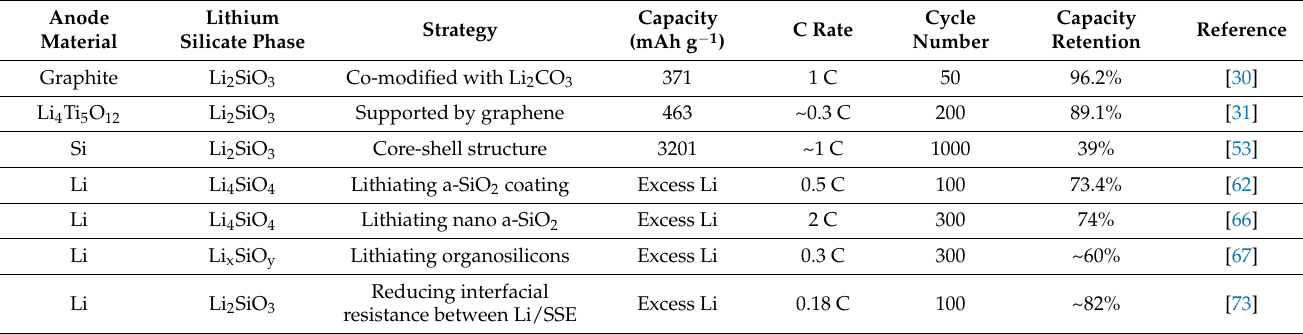
Table 1. Electrochemical performance of anode materials protected by lithium